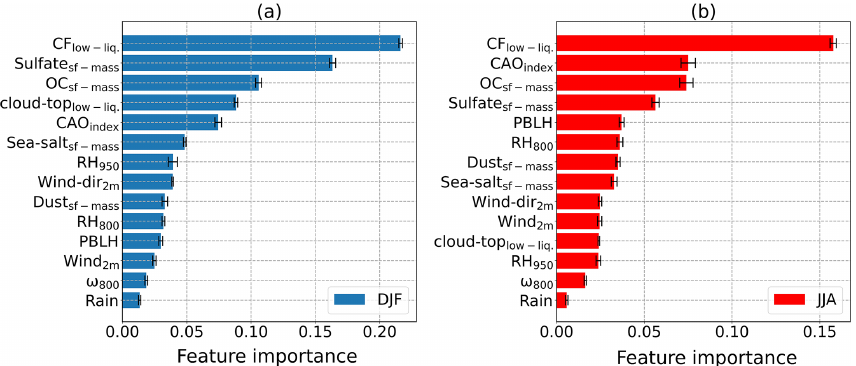
Figure 13. Average permutation feature importance of input parameters for (a) DJF and (b) JJA based on GBRT models trained in each season. Feature importance values were calculated based on using the test set. Error bars exhibit the range of feature importance values stemming from the variability of the obtained models from the cross-validation resampling procedure.